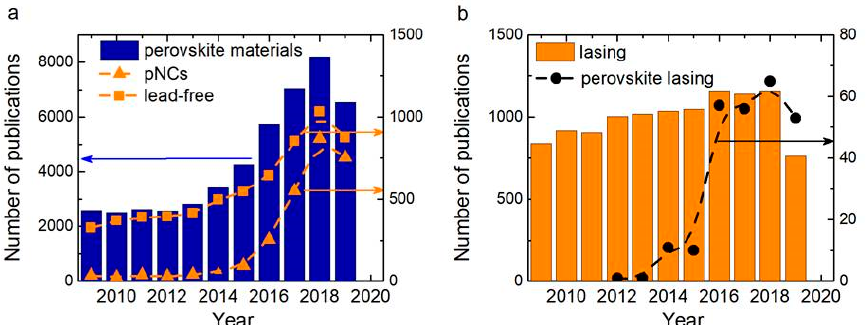
Figure 1. ( a ) Plot of publications number in the last decade: on perovskite materials (blue columns), on lead-free perovskite materials (orange squares), and on perovskite NCs (orange triangles). ( b ) Plot of publications number in the last decade: On lasing (orange columns), on lasing in perovskite materials (black circles).